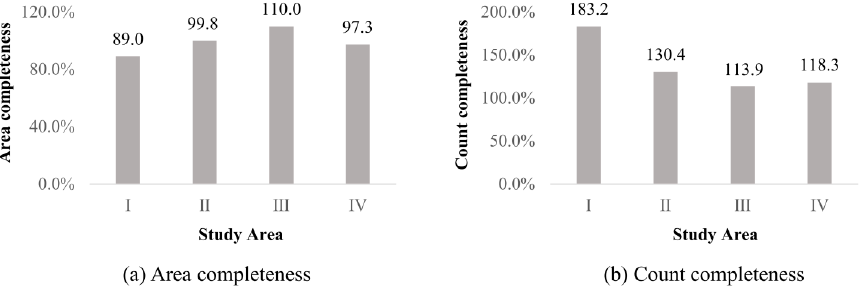
Figure 6. Results of the area completeness and count completeness for the four study areas (I, II, III and IV).